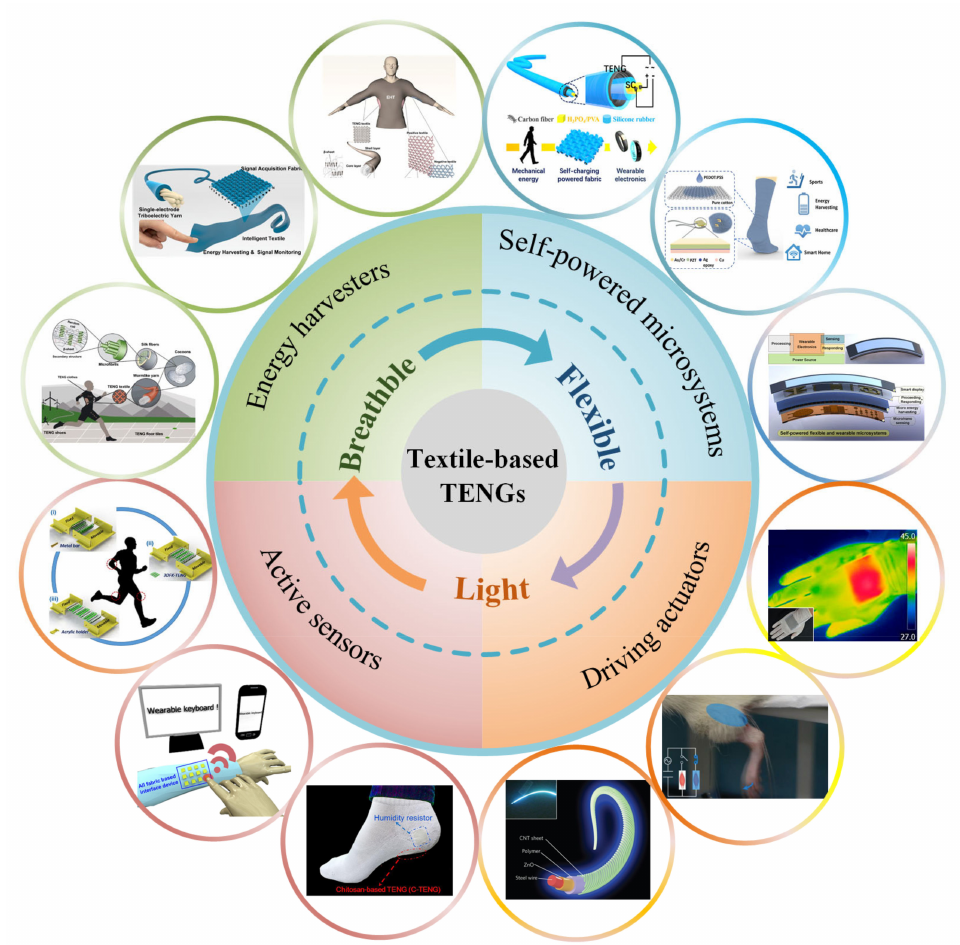
Figure 1. Self-powered microsystems based on textile-based triboelectric nanogenerators (T-TENG). T-TENG has many outstanding characteristics, including flexibility, breathability, and light weight, etc. It can form different T-TENGs in the form of fibers or fabrics, and the different weaving methods used can adapt to different situations. T-TENG can be used as energy harvesters, active sensors, and drive actuators, which can form microsystems. “Energy harvesters”. Reproduced with permission from Springer Nature (2017) [36]. Reproduced with permission from American Chemical Society (2020) [37]. “Active sensors”. Reproduced with permission from Elsevier (2018) [24]. Reproduced with permission from Elsevier (2018) [28]. Reproduced with permission from Elsevier (2020) [38]. “Driving actuators”. Reproduced with permission from American Chemical Society (2016) [39]. Reproduced with permission from Wiley (2019) [33]. Reproduced with